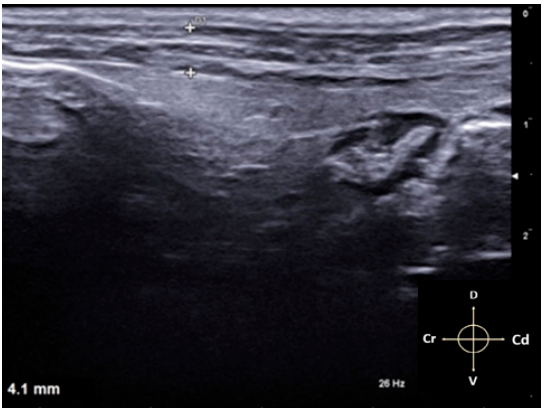
Figure 3. Measurements of TAP thickness in millimetres (mm). The muscle planes were measured from the SC to the peritoneum. Arrows indicate cranial (Cr), caudal (Cd), dorsal (D) and ventral (V) directions respectively.